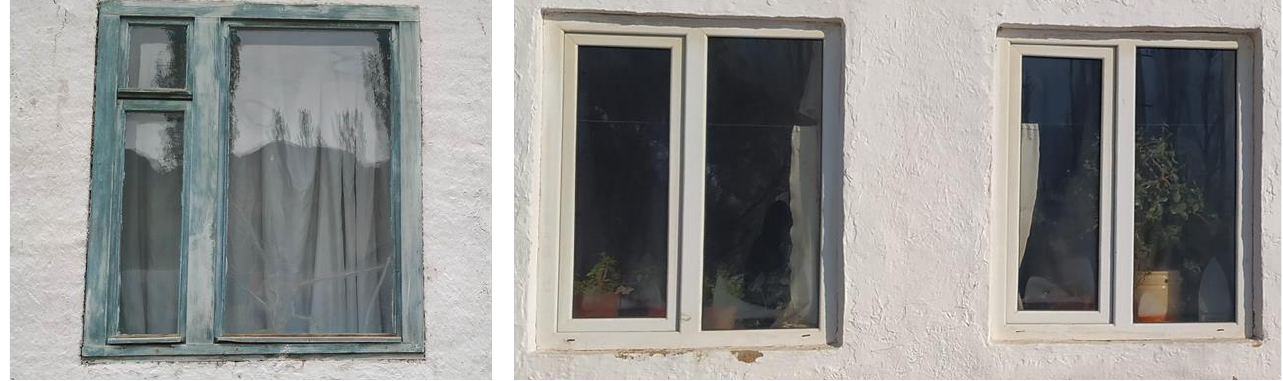
Figure 18. Traditional wooden windows ( left ) and newly installed PVC windows ( right ).